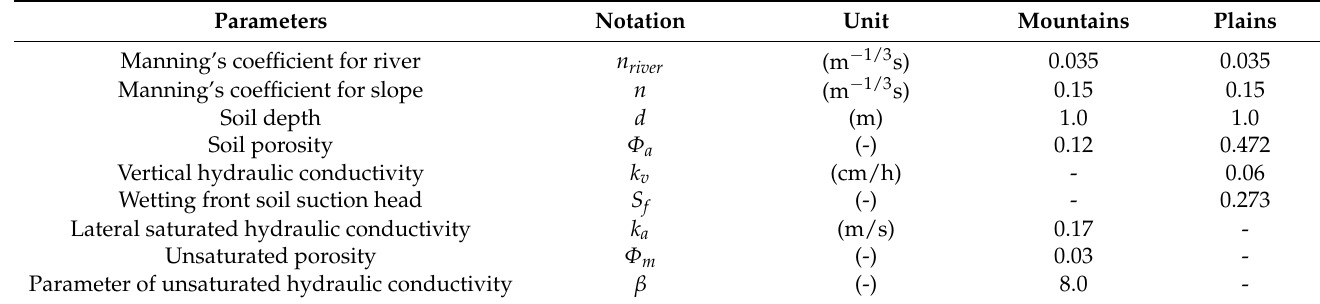
Table 1. Optimal parameter settings of the RRI